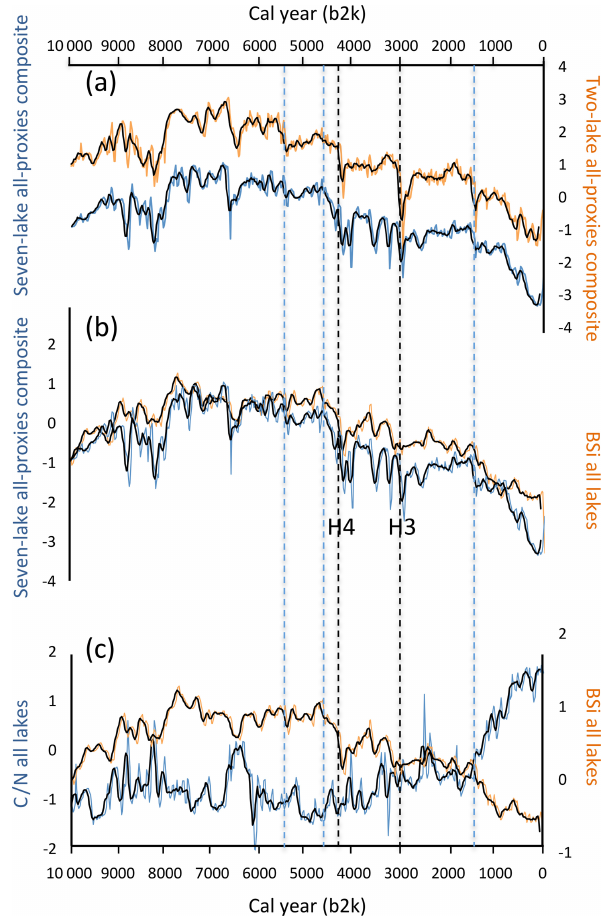
Figure 5. (a) Composite records of all seven lakes combined com- pared to the two-lake composite of Geirsdóttir et al. (2013), (b) BSi composite of all seven lakes compared to composite of all proxies in seven lakes, (c) BSi all lakes, and C / N all lakes. Dashed lines mark the step changes